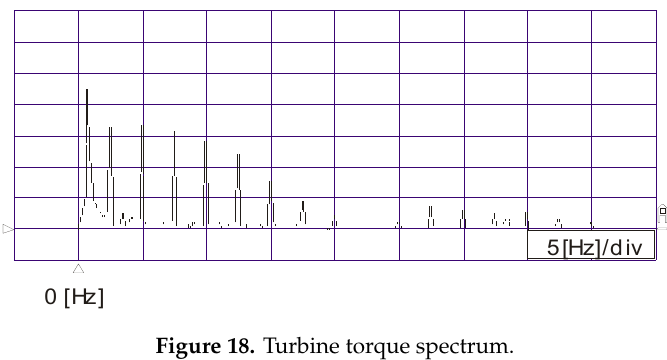
Figure 18. Turbine torque spectrum.